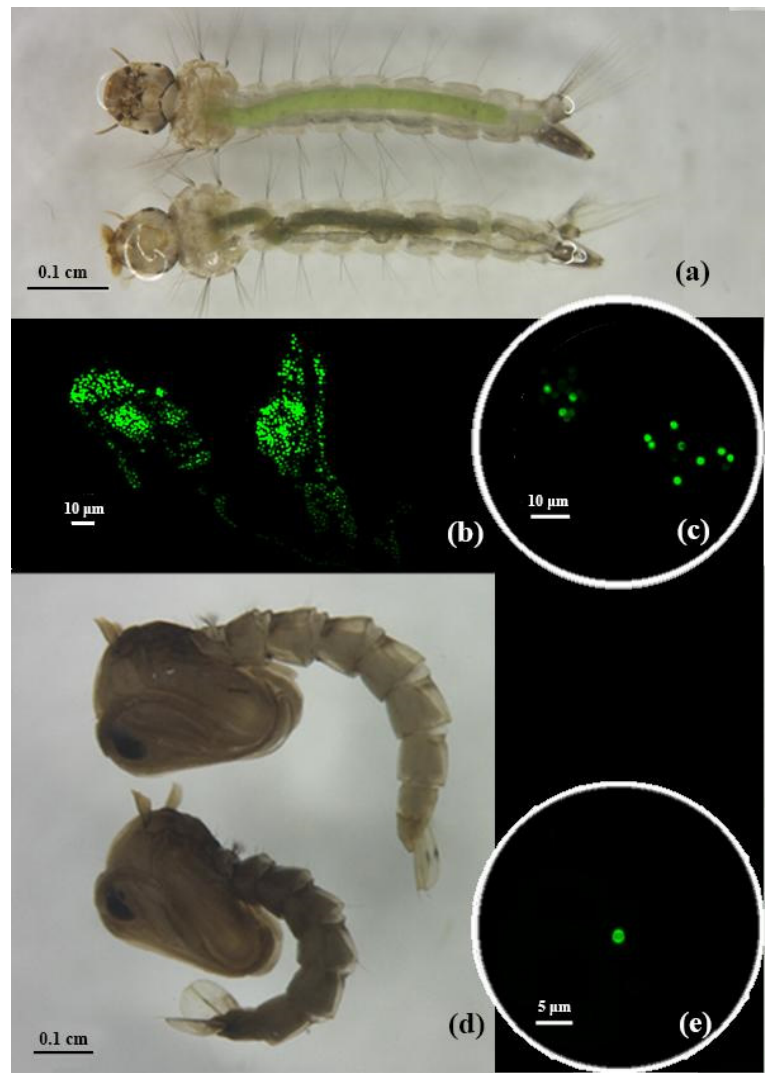
Figure 1. Habitus of Ae. aegypti larvae from the experimental group on top (intestines filled with MPs), larva from the control group on the bottom, light microscopy ( a ); thin section of the intestine of the larvae from the experimental group ( b ) and microspheres detected in larvae ( c ), epifluorescent microscopy; habitus of Ae. aegypti pupa from the experimental group on top, pupa from the control group on bottom, light microscopy ( d ); microspheres detected in pupa, epifluorescent microscopy ( e ).